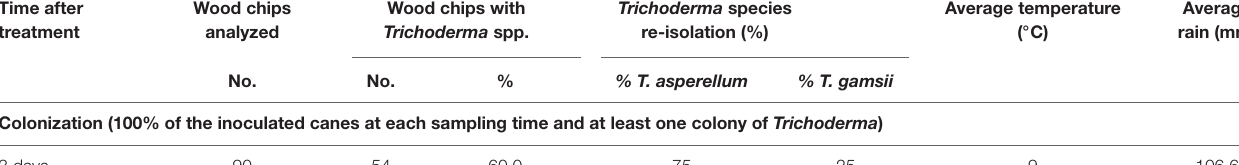
Average temperature Average ( ◦ C) rain (mm)